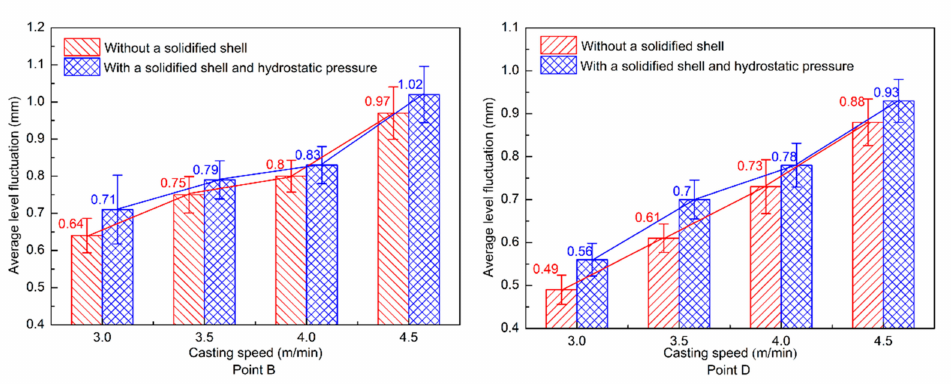
Figure 9. Level fluctuation in the free surface of the hydraulic modeling experiments with and without a solidified shell and hydrostatic pressure at the measurement point B and point D for various casting